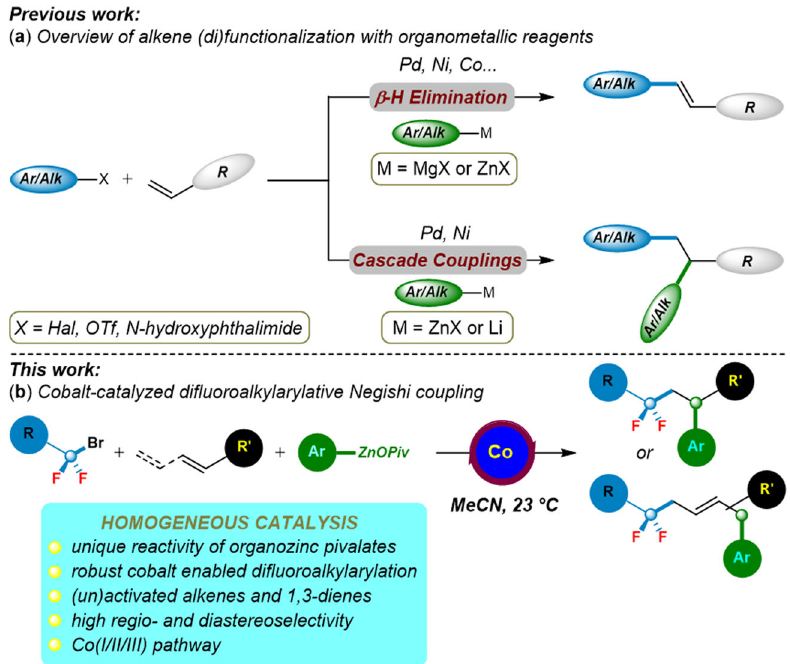
Fig. 1 Background and our objective. a Organometallic reagents for difunctionalization of ole fi ns. b Organozinc pivalates for cobalt-catalyzed di fl uoroalkylarylation of ole fi ns.